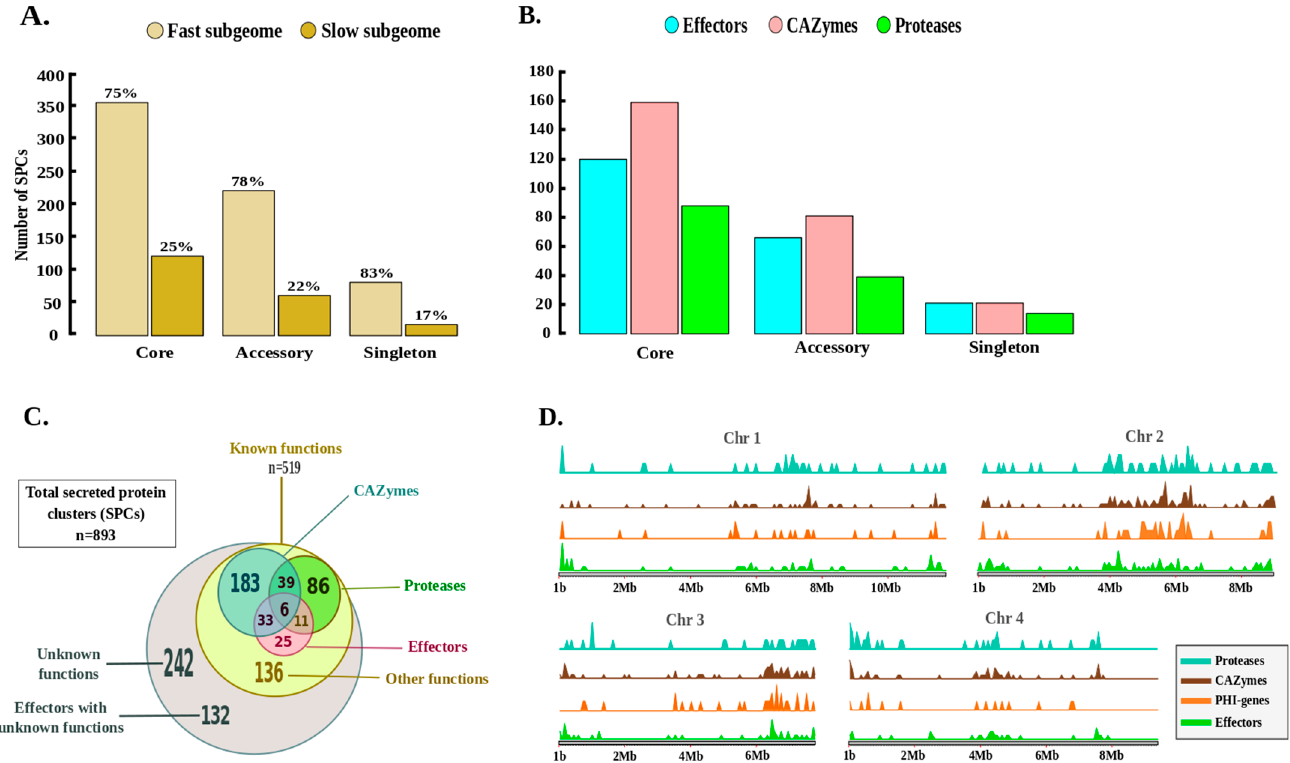
Figure 6. Characterization of the F. graminearum pan-secretome. ( A ) Categorization of putative secreted protein clusters (SPCs) of the eight F. graminearum strains into core, accessory and singleton secreted proteins. In each of the three categories, the percentage of SPCs assigned to the fast and slow sub-genome is reported. ( B ) The bar graph depicts the number of SPCs encoding CAZymes, proteases and putative proteinaceous effectors (according to EffectorP v2.0) in each of the three pan-secretome categories. ( C ) The Venn diagram depicts the number of SPCs displaying one or more labels (among CAZyme, protease or effector), as well as those with no predicted functions. ( D ) Density and localization of the genes encoding secreted CAZymes, secreted proteases, secreted effectors and genes potentially involved in the host–pathogen interaction (according to PHI-base) along the four F. graminearum chromosomes. The size of the chromosomes is in Mb, in 2 Mb increments.